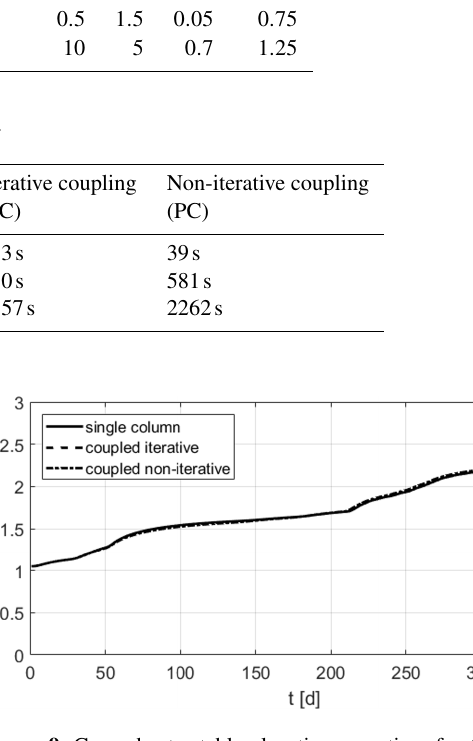
Figure 9. Groundwater table elevation over time for the 1D flow